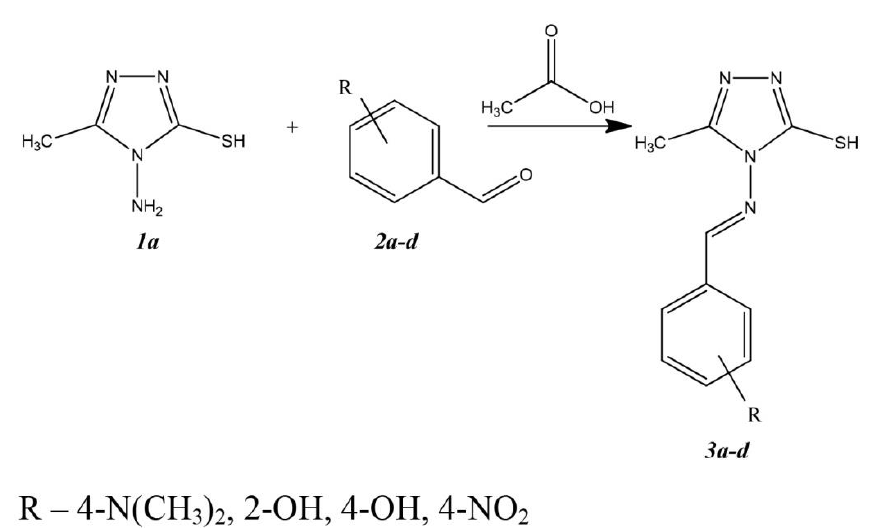
Fig. 1. Synthesis scheme for 4-(R-arylideneamino) -5-methyl-4H-1,2,4-triazole-3-thiols ( 3a-d